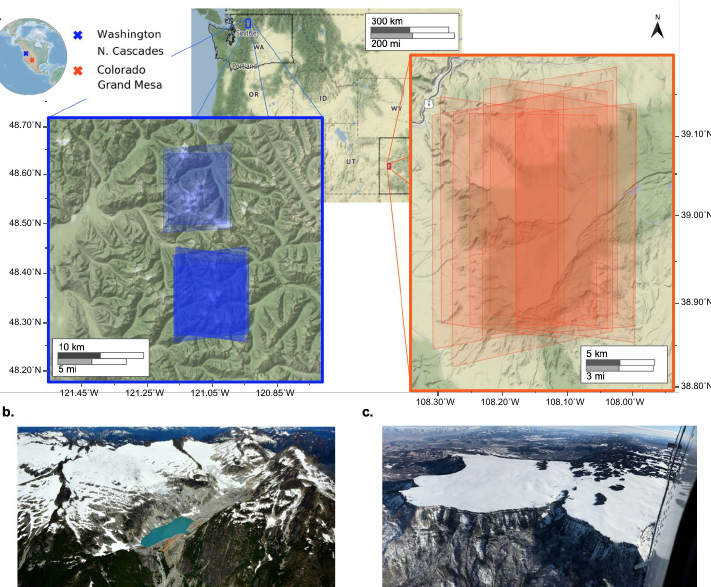
Figure 1. ( a ) Study site locations with VHR image footprints over shaded relief basemap: North Cascades, WA, USA (left in blue, southern footprints show images over South Cascade Glacier) and Grand Mesa, CO, USA (right in orange). Oblique aerial context images of ( b ) mountain peaks and an alpine lake in the North Cascades site (July 2017, photo courtesy of Long Bach Nguyen) and ( c ) the north arm of the Grand Mesa site (February 2017, photo courtesy of Chris